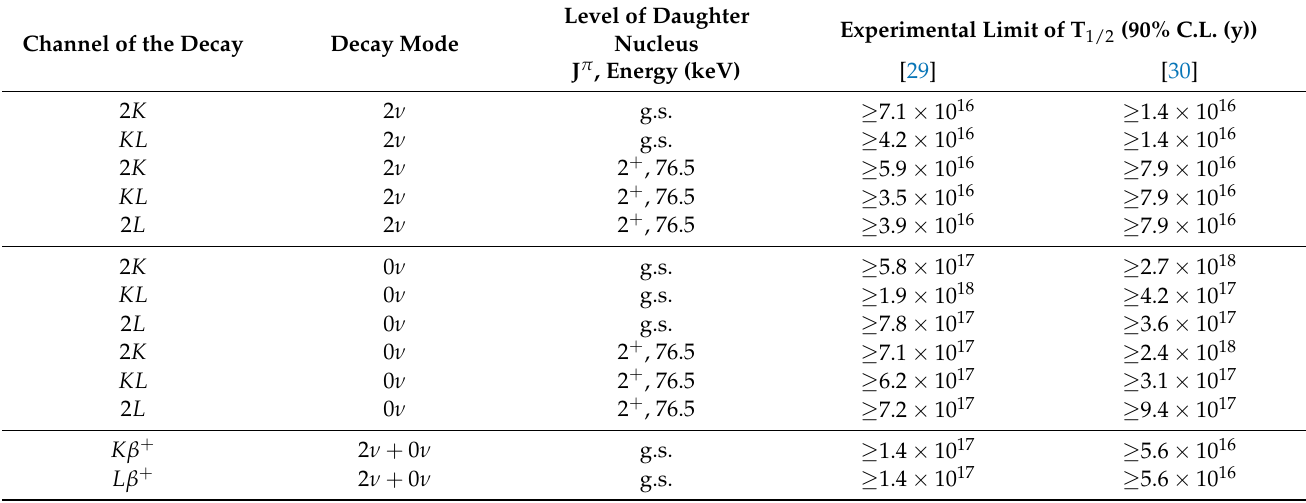
Table 2. The half-life limits of 2 (cid:101) and (cid:101)β + processes in 174 Hf as performed in Refs. [29,30].